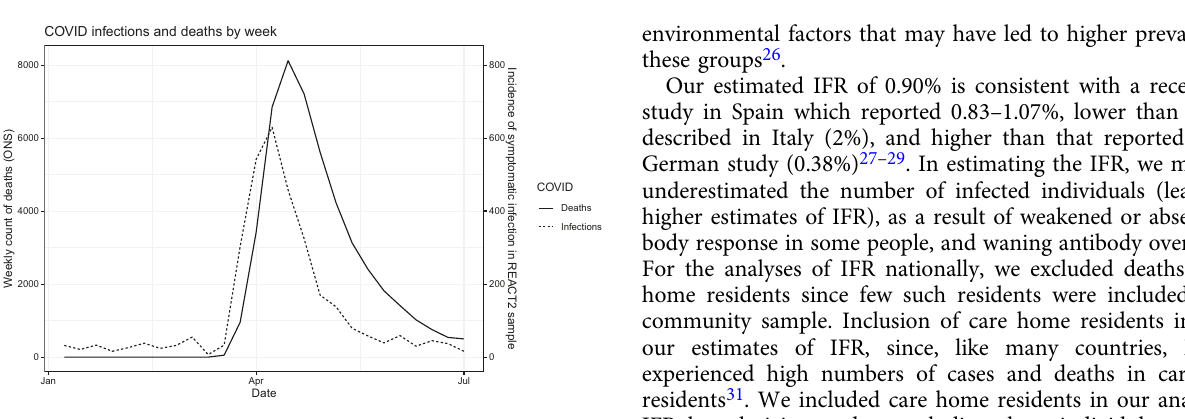
Fig. 1 Reconstruction of epidemic curve from REACT-2 alongside national reported deaths from COVID-19. Number of symptomatic infections by week (dotted line; right y axis) based on the date of onset among 3493 antibody-positive participants who reported symptoms in the REACT-2 study, compared with deaths by week in England (solid line; left y axis. Data from Of fi ce for National Statistics 46 ). Source data are provided with this paper.